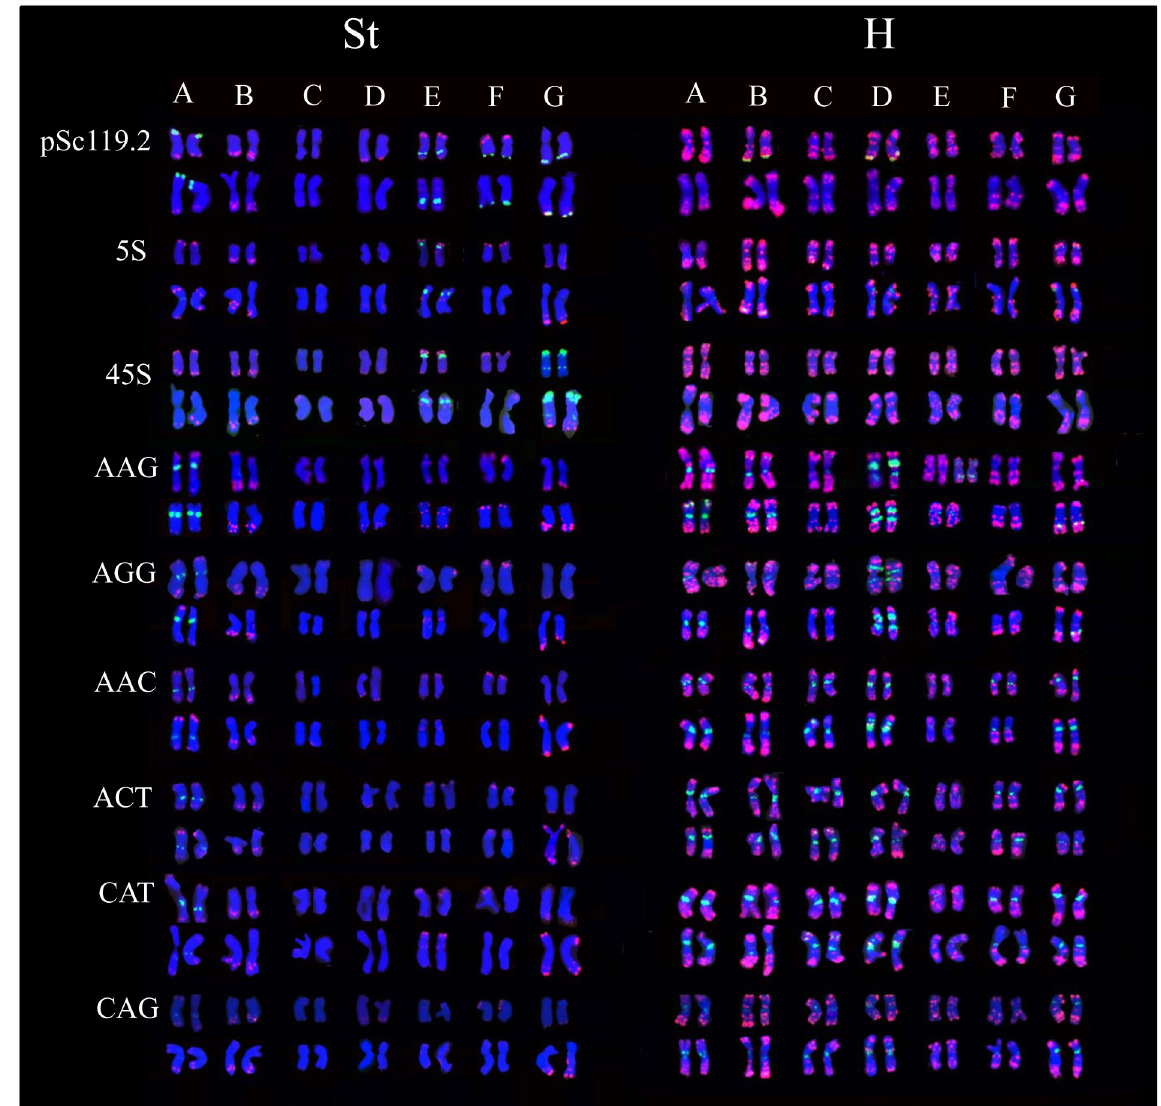
Fig 2. Molecular karyotyping of the two cultivars of Elymus sibiricus combined with Oligo-pAs1 (red) and different repetitive sequences (green) . The upper panel shows the karyotype for Tongde and the lower for Nongmu, for each characterization.